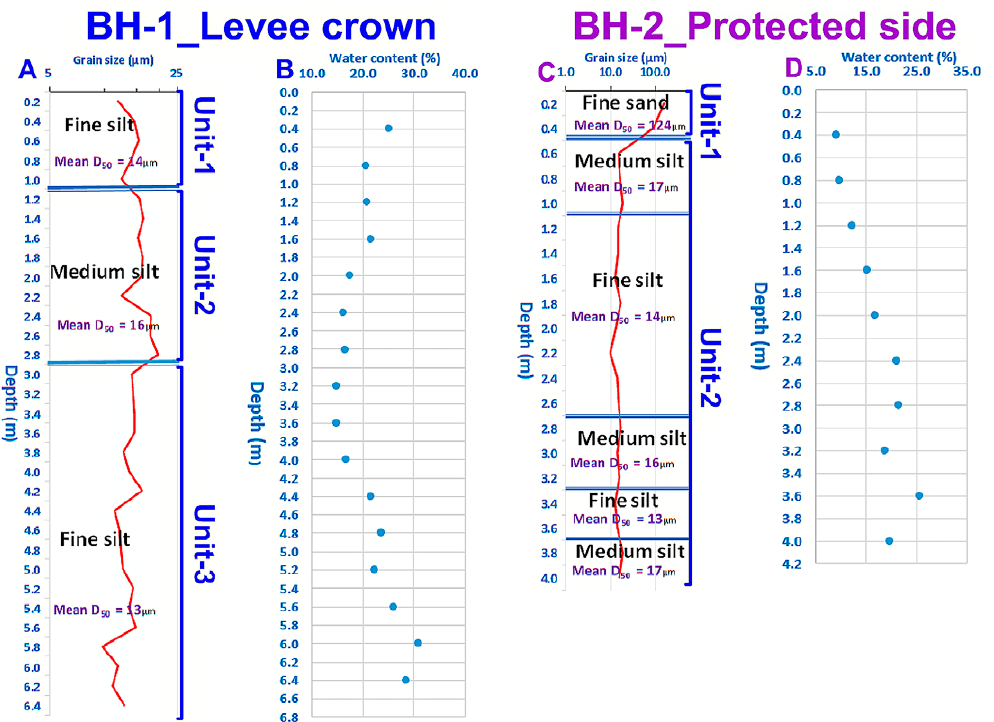
Figure 5. Vertical change of mean grain size (D